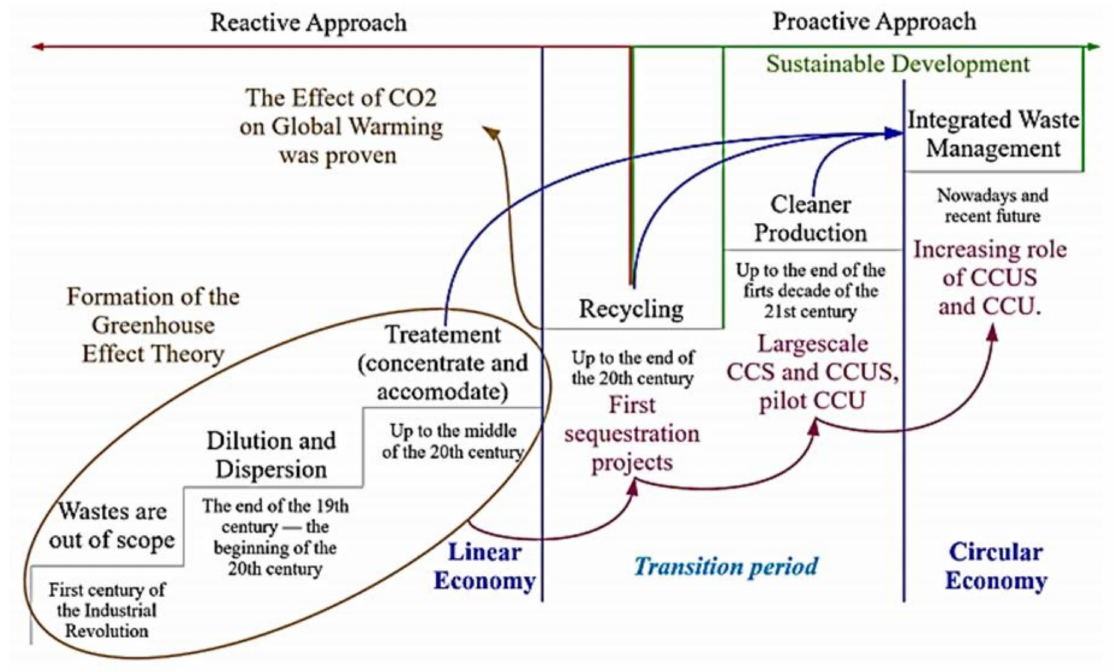
Figure 10. The impact of carbon sequestration projects on the transition from linear to circular [201], open